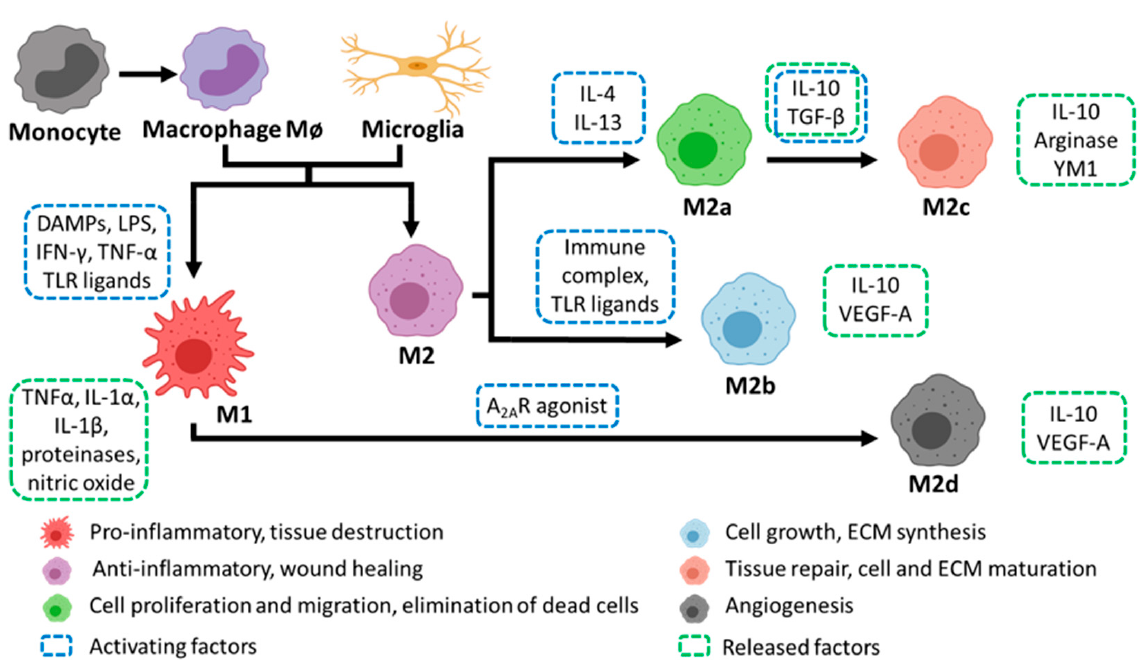
Figure 1. Schematic diagram of macrophage polarization after nerve injury. Macrophages constantly undergo phenotypic polarization depending on the current environmental stimuli. M1 macrophages are activated by TLR ligands, LPS, TNF α , IFN- γ . Activation into M2 macrophages occurs when macrophages are exposed to IL-4, IL-13, TGF- β , immune complexes and A2AR agonist. (Adapted from [3,4], Wolters Kluwer, 2019 and Springer Berlin Heidelberg, 2015. Created with Biorender ® ).